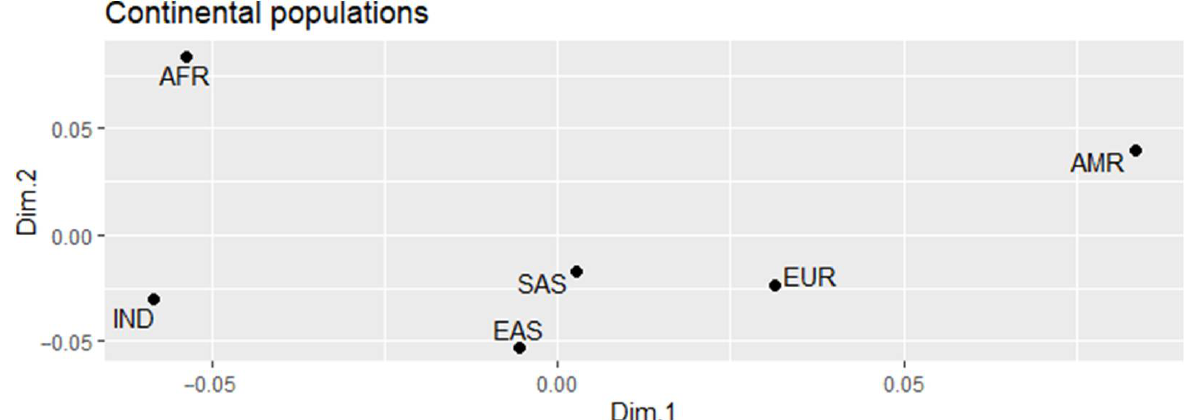
Figure 1. Multidimensional scale graph illustrating the ethnic populations grouping according to the genetic profile of the 35 variants in the CHD8 , SCN2A , FOXP1 , and SYNGAP1 genes.